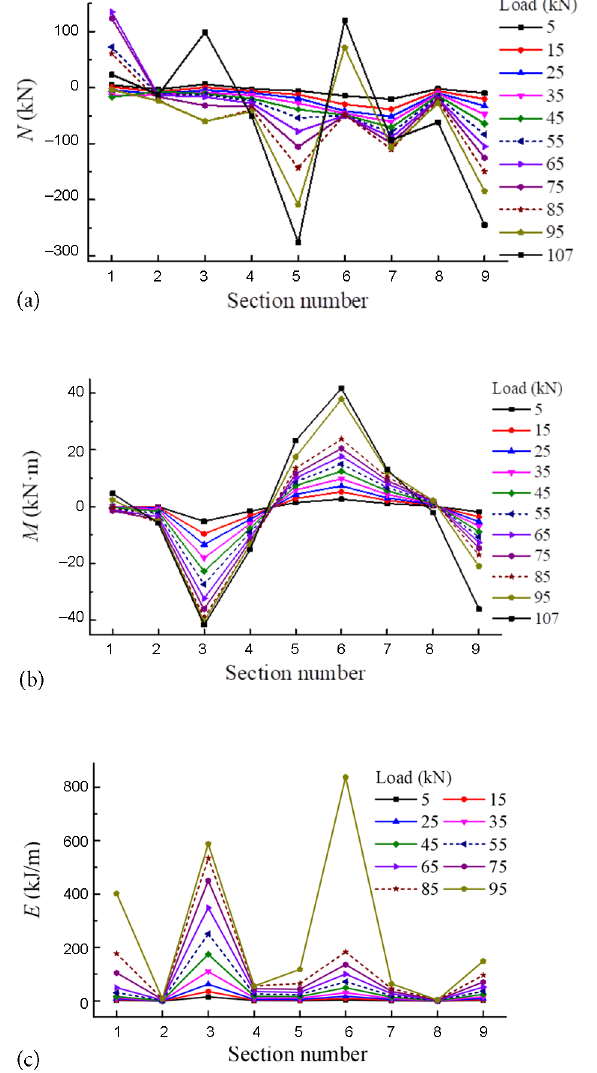
Figure 11. The stressing state submodes for internal forces of arch D: a – the distribution mode of axial force N ; b – the distribution mode of bending moment M ; c – the distribution mode of GSED